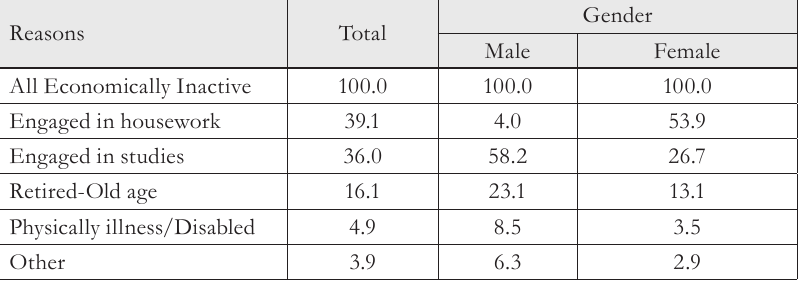
Tab. 2 - Reasons of being economically inactive by gender. Source: Labour Force Survey - Annual Report